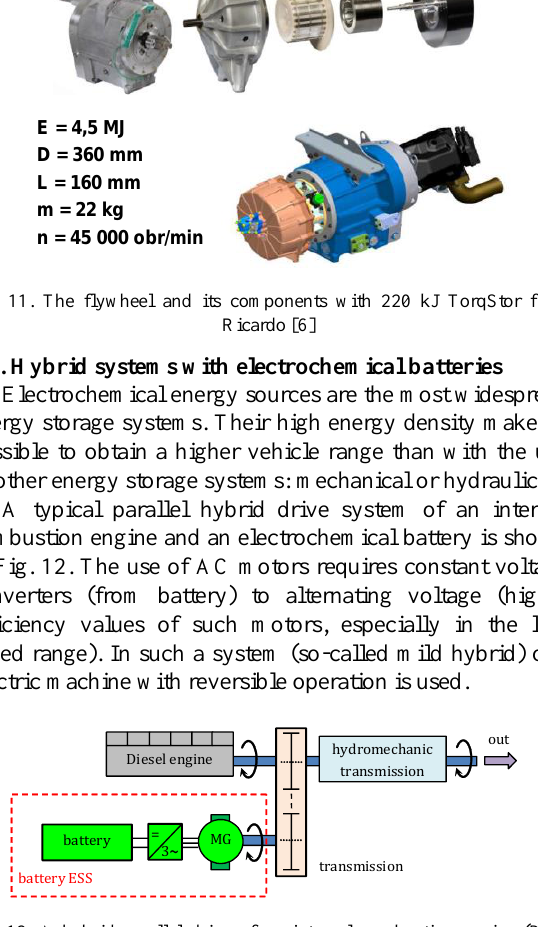
Fig. 12. A hybrid parallel drive of an internal combustion engine (DM) with a hydromechanical transmission, a battery system and an electric motor [14, 17]